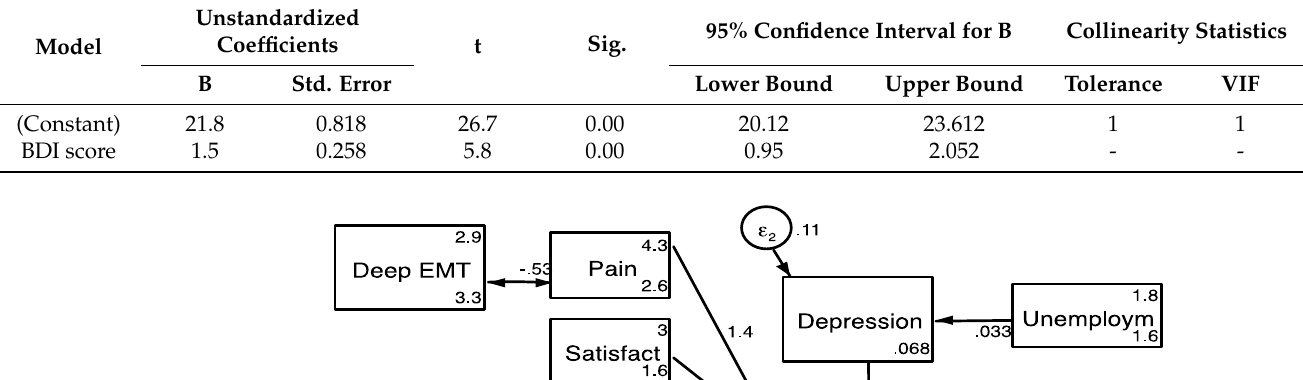
Table 7. Linear multiple regression. Best fitting model R square 0.694. VIF, variance inflation factor.